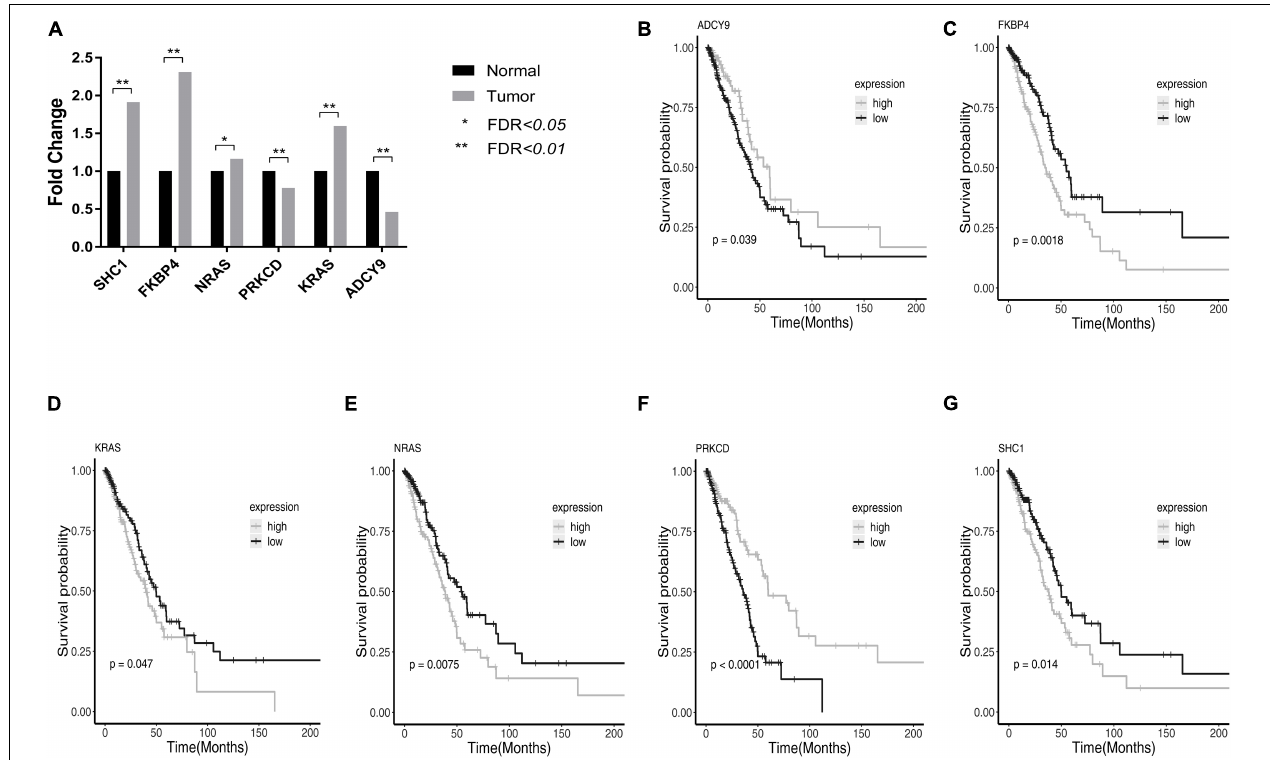
FIGURE 2 | The relative expression and survival curves of the six genes with FDR < 0.05 in TCGA LUAD dataset. (A) The bar graph showed the relative expression of PRKCD, ADCY9, SHC1, FKBP4, NRAS , and KRAS among LUAD tumor tissues and normal tissues in TCGA LUAD dataset. (B–G) High expression of PRKCD and ADCY9 prolonged the survival time of LUAD patients and the high expression of SHC1, FKBP4, NRAS , and KRAS reduced the survival time of LUAD